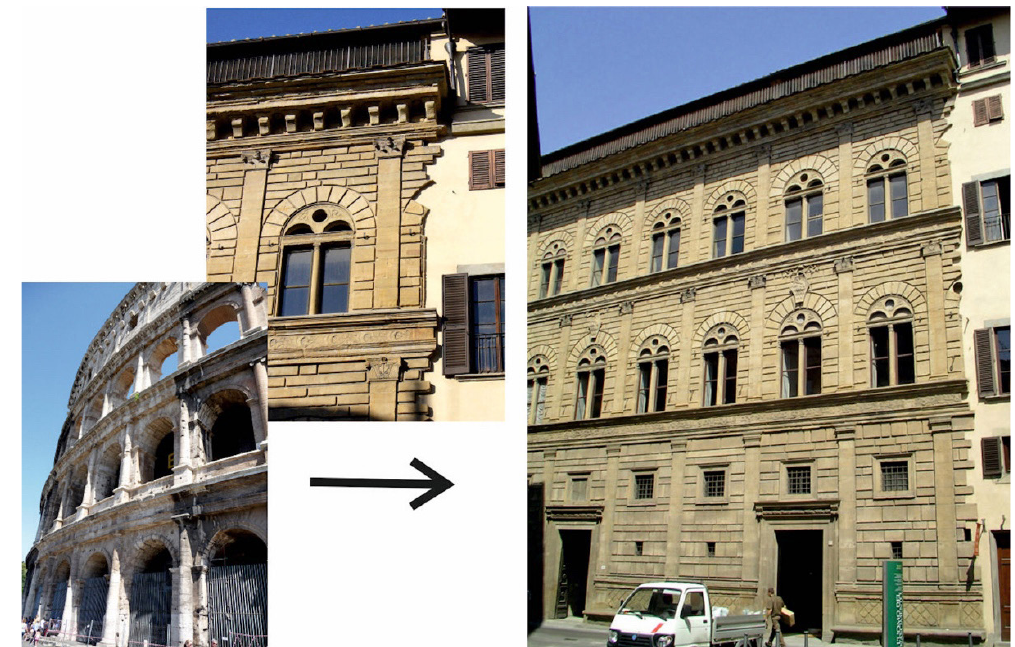
Figure 2. Comparison of the facade of the Palazzo Rucellai with the